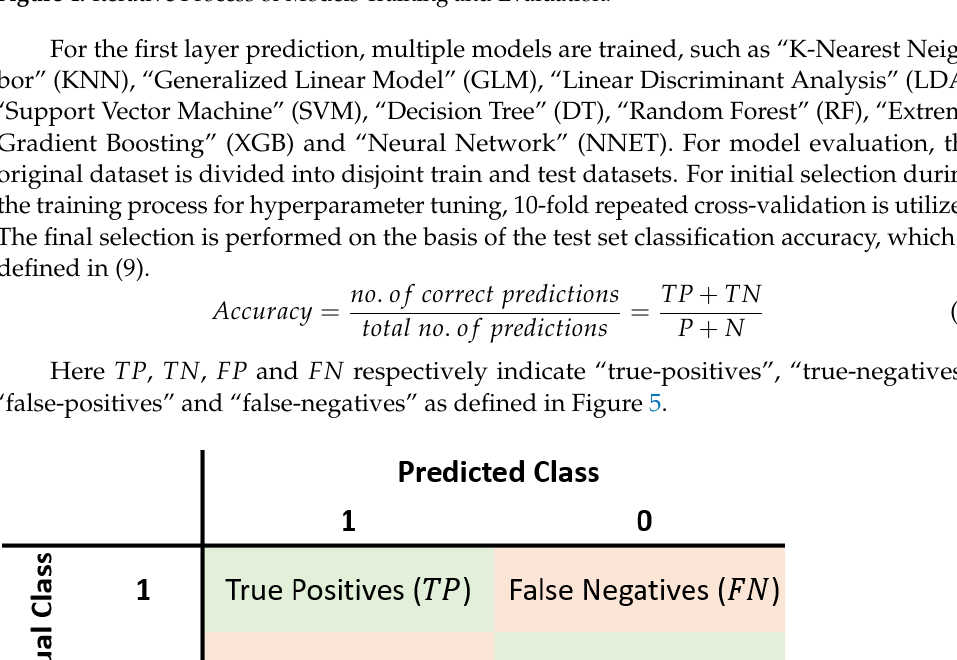
Figure 4. Iterative Process of Models Training and Evaluation.